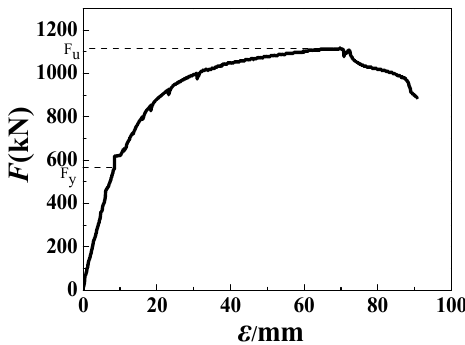
Figure 5. Loading device and schematic diagram of the specimen.